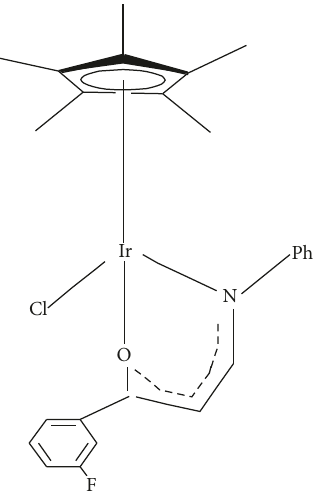
Figure 3: Iridium(III) ketoiminate